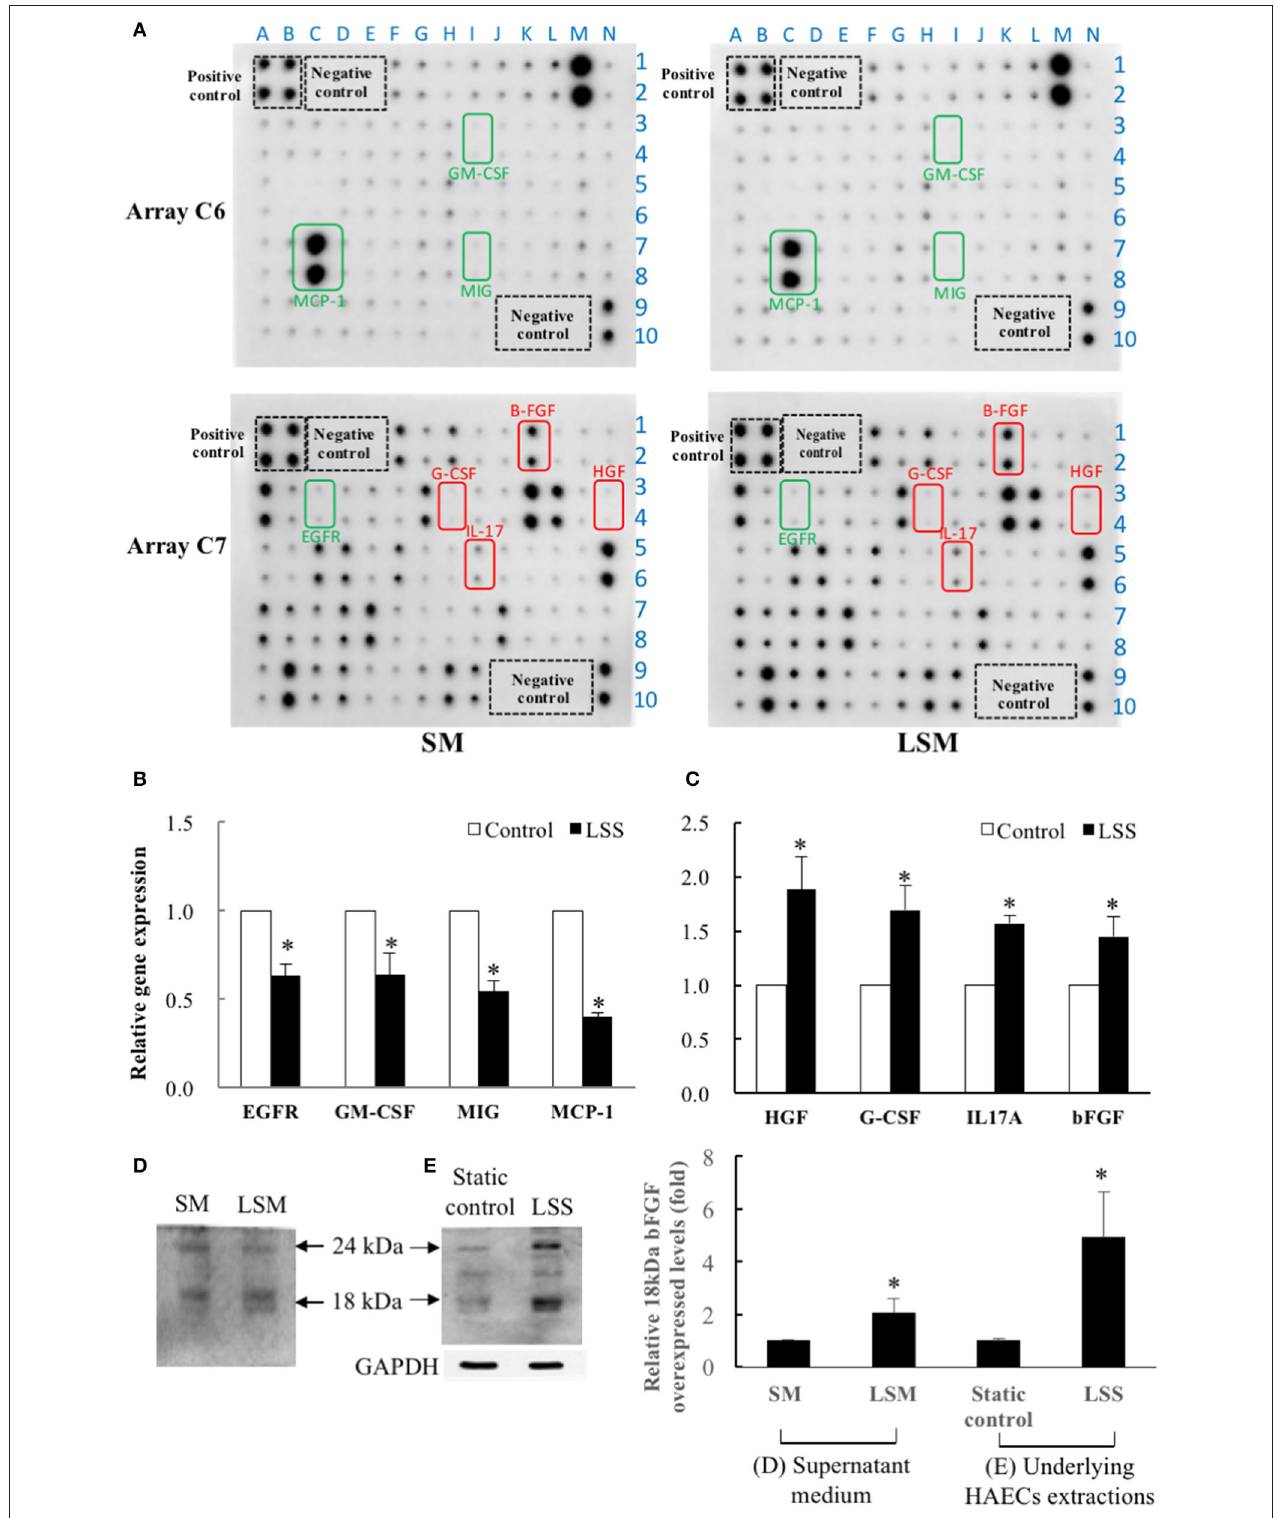
FIGURE 4 | Quantification of HAEC-secreted cytokines in SM from static control and LSM from new LSS device by Human Cytokine Antibody Array C1000. (A) Left panels show SM data and right panels show LSM data. Array C6 is shown in upper two panels and array C7 is shown in bottom two panels.